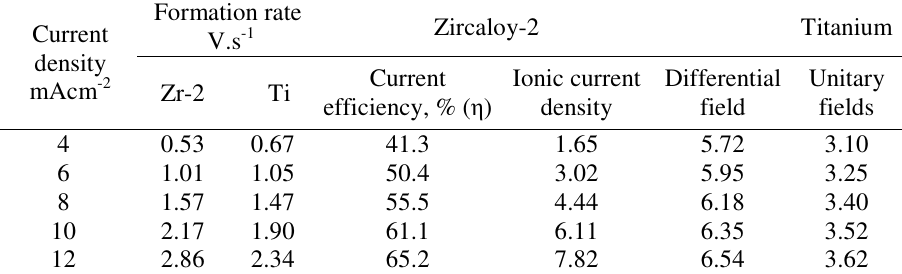
Table 3. Data on the anodization of Zr-2 and Ti in 0.1 M picolinic